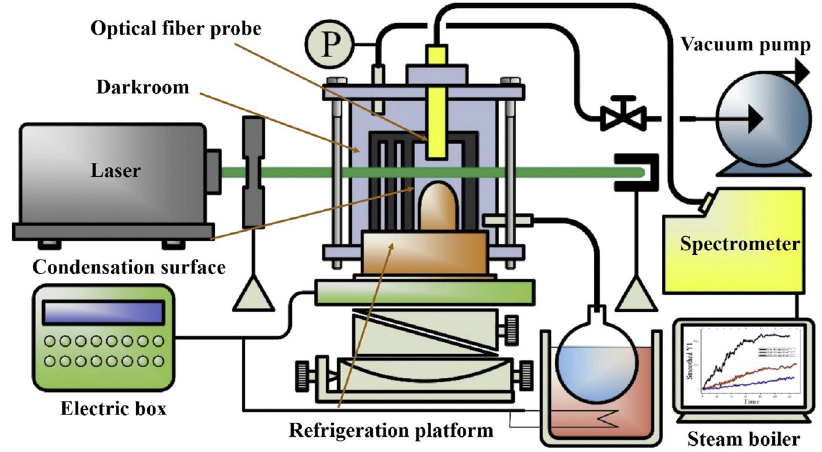
Figure 5. Scheme of cluster condensation near